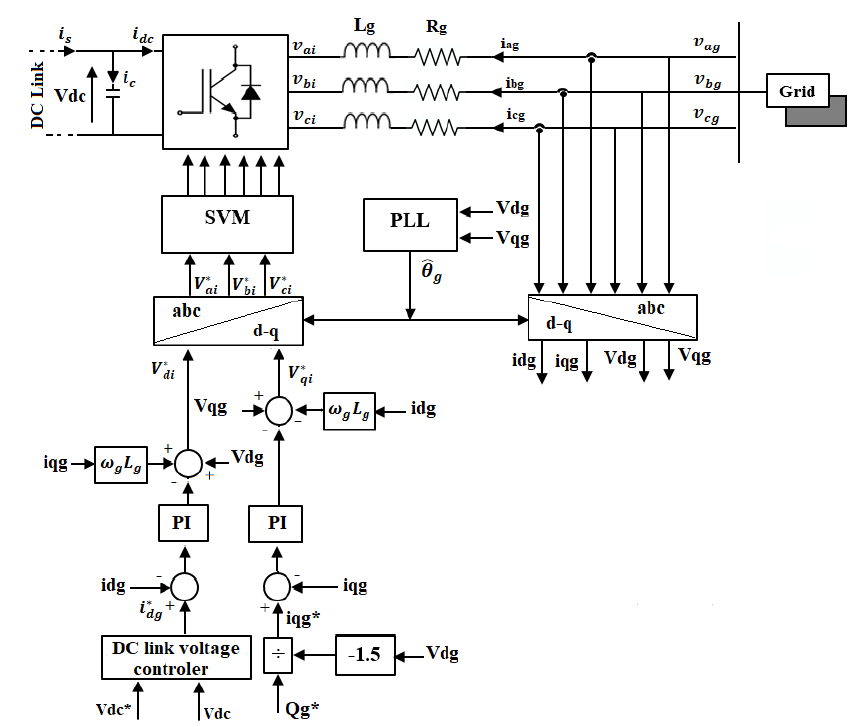
Figure 2. Structure of the voltage oriented control (VOC) for the grid-side